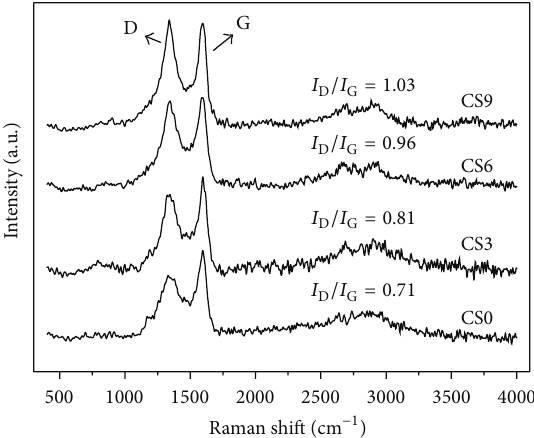
Figure 5: Raman spectra for the samples prepared by CO 2 activa-